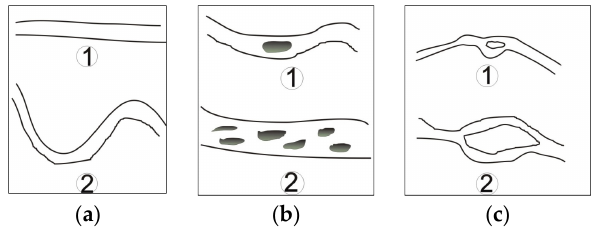
Figure 2. River planform classification based on the degrees of sinuosity, braiding and anabranching. ( a ) Different degrees of sinuousity, the degree of sinuousity of river planform 2 is higher than that of river planform 1; ( b ) different degrees of braiding, the degree of braiding of river planform 2 is higher than that of river planform 1; ( c ) different degrees of anabranching, the degree of anabranching of river planform 2 is higher than that of river planform 1.